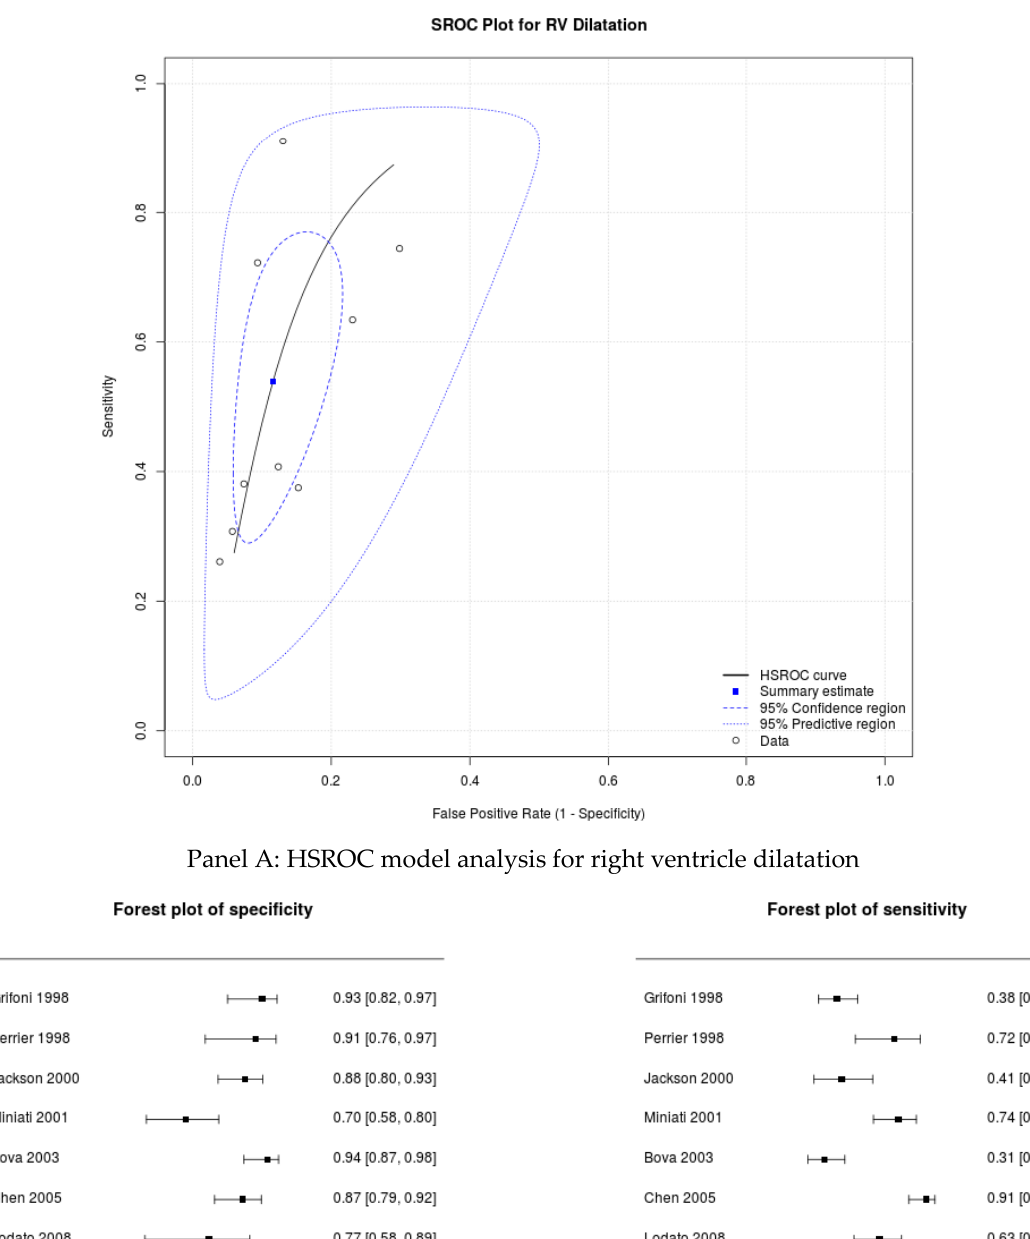
Panel B: Forest Plot of Sensitivity and Specificity of right ventricle dilatation Figure 2. HSROC model and Forest Plot for right ventricle dilatation . Figure 2. HSROC model and Forest Plot for right ventricle